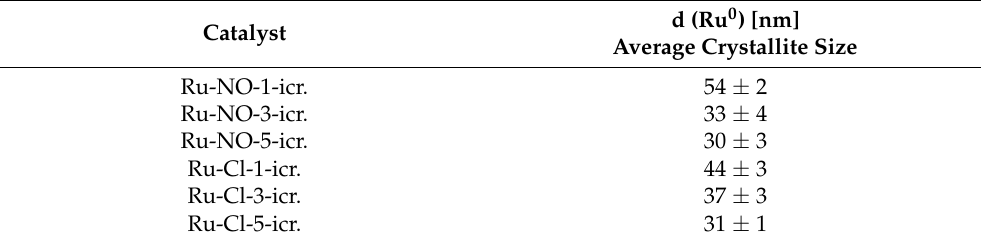
Table 4. Crystallite size determination with Scherrer equation for the catalysts at the reduced state.